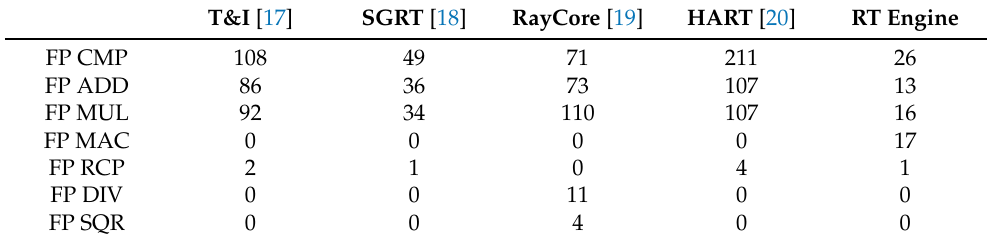
Table 4. Complexity of our design in terms of the number of floating-point units(RCP: reciprocal unit, ADD: adder, MUL: multiplier, MAC: multiply accumulate, CMP: comparator, DIV: divider, SQR: square